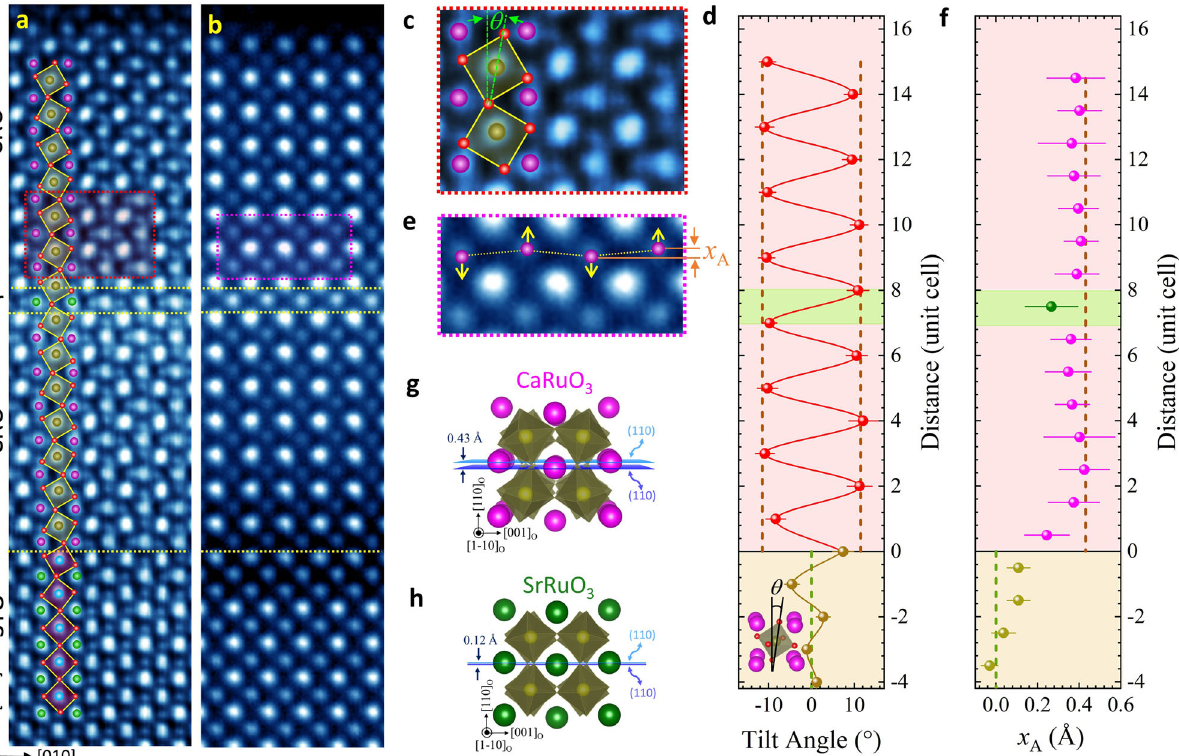
Fig. 2 Atomically resolved structure of CRO 7 -SrO-CRO 8 heterostructure. a intensity-inversed annular bright fi eld (ABF), and b High-angle annular dark- fi eld (HAADF) images representing domain A and B, respectively. c Zoom-in image of the area marked in a superimposed by projected octahedra and tilt angle ( θ ), and d θ as a function of distance from the fi lm-substrate interface. e Zoom-in image of the area marked in b superimposed by the corresponding A-site cation displacement ( x A ), and f x A versus atomic distance. The arrows in e mark the A-site displacement direction thus forming an up-down buckling pattern in AO plane. The dashed lines in d and f represent the value of θ and x A of bulk CRO (brown) and STO (green), respectively. Schematic of the bulk crystal structure of g CRO and h SRO showing A-site displacement projected along [1 – 10] O direction. The top (110) plane (light blue) passes through the center of the left and right Ca (Sr) atom, and the dark blue (110) plane bisects the center of the middle Ca (Sr)-atom, whereas the projected A-site displacement corresponds to the distance between the two parallel planes. The error bar in panels d and f indicates the standard deviation of averaged measurement for each vertical atomic